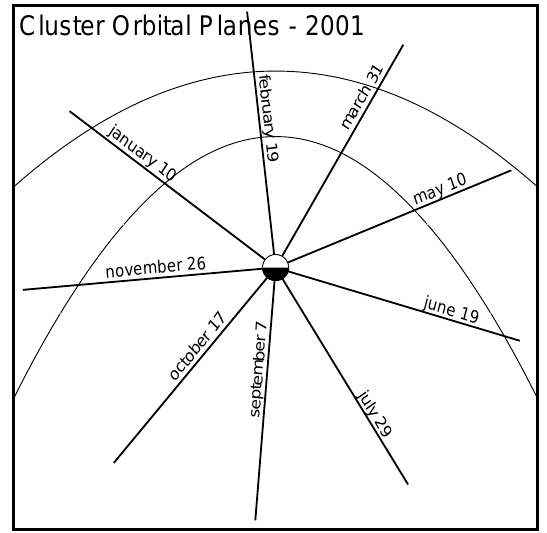
Fig. 1. The meridian of the Cluster orbit clocks through all local times of the year supporting dayside, flank, and nightside investiga-